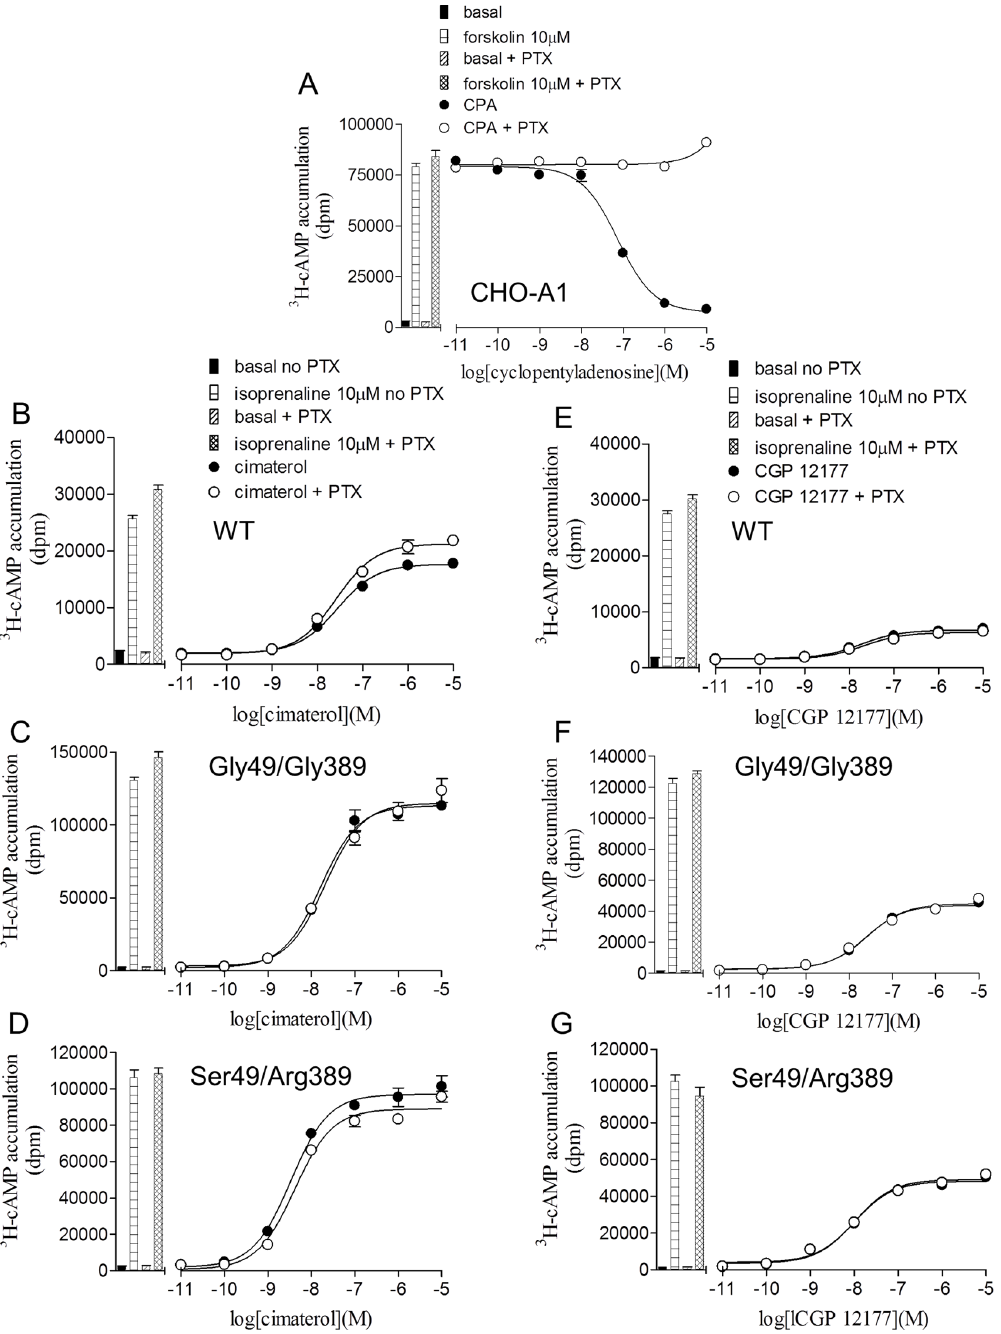
Figure 6. The effect of pre-incubation with pertussis toxin on 3 H-cAMP accumulation responses. 3 H-cAMP accumulation in A CHO cells expressing the human adenosine A1 receptor, B and E wildtype b 1-adrenoceptor cells, C and F Gly49/Gly389 cells and D and G Ser49/Arg389 cells. All cells were subjected to 24 hours in serum free media before experimentations, those with closed circles in the absence of PTX and those with open circles in the presence of PTX. Bars represent A basal 3 H-cAMP accumulation and that in response to 10 m M forskolin, B–G basal 3 H-cAMP accumulation and that in response to 10 m M isoprenaline following incubation in serum free media without and with PTX. Data points are mean 6 s.e.mean of triplicate determinations and these single experiments are representative of 4 separate experiments in each case. A demonstrates that the PTX pre-incubation was successfully preventing the Gi-coupled responses to cyclopentyladenosine (CPA) in CHO cells expressing the human A1 adenosine receptor, however there was no effect of PTX pre-incubation on the cimaterol (catecholamines conformation) or CGP 12177 (secondary conformation) responses occurring via the wildtype human b 1-adrenoceptor or the polymorphic variants.